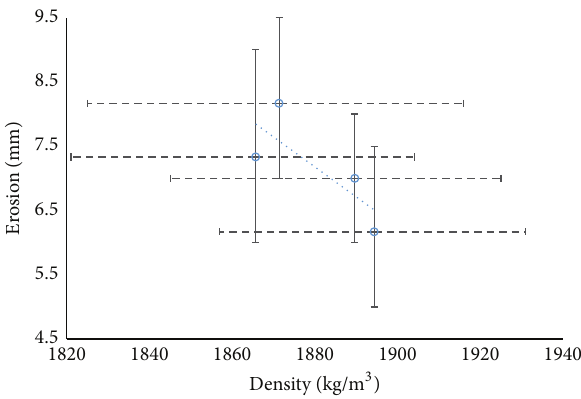
Figure 10: Tensile strength of compressed earth blocks (error bars represent range of data obtained) .